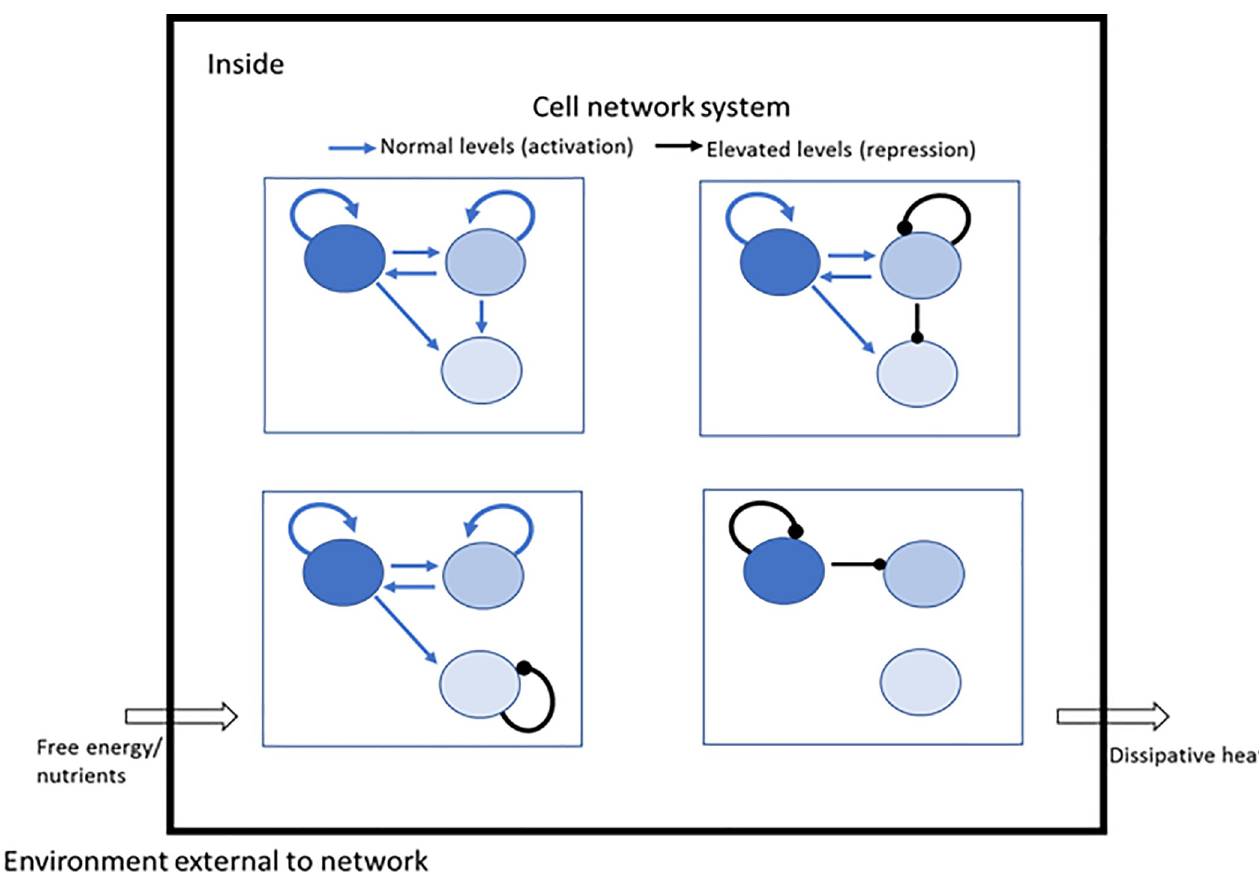
Fig 1. Schematic of an intracellular network. This is based on concepts presented by Rizzino and Wuebben [32] on control of pluripotency, and consists of N = 3 variable components, or dimensions, of a network with activation and repression relationships as indicated. As described in the text, these relationships define the measurable covariances in an NxN diffusion matrix, which contribute to the thermodynamics of the network together with the gradients of a landscape (which are derived from the multi-dimensional steady state probability density). The nonequilibrium steady state in this open thermodynamic system is supported by an influx of free energy from outside the system, which is dissipated as